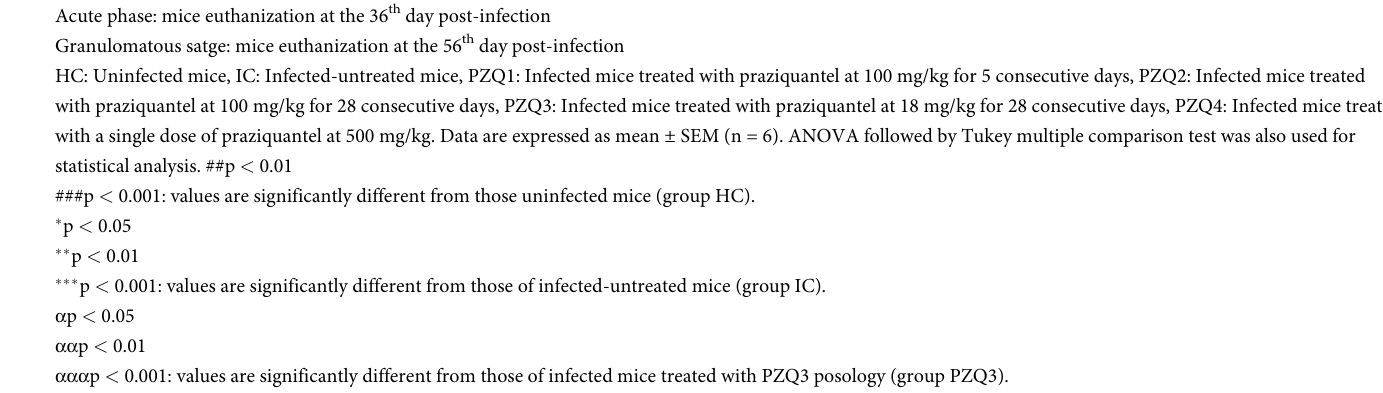
Acute phase: mice euthanization at the 36 th day post-infection Granulomatous satge: mice euthanization at the 56 th day post-infection HC: Uninfected mice, IC: Infected-untreated mice, PZQ1: Infected mice treated with praziquantel at 100 mg/kg for 5 consecutive days, PZQ2: Infected mice treated with praziquantel at 100 mg/kg for 28 consecutive days, PZQ3: Infected mice treated with praziquantel at 18 mg/kg for 28 consecutive days, PZQ4: Infected mice treated with a single dose of praziquantel at 500 mg/kg. Data are expressed as mean ± SEM (n = 6). ANOVA followed by Tukey multiple comparison test was also used for statistical analysis. ##p <